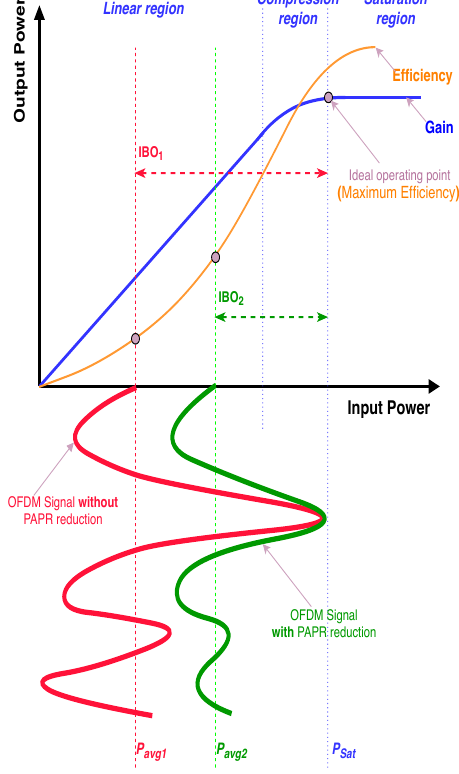
Figure 1. General AM/AM characteristic of